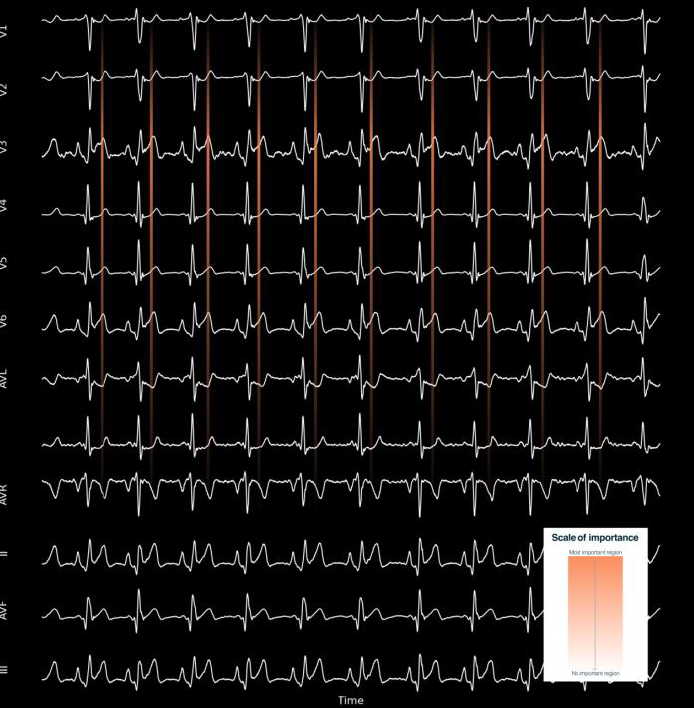
Figure 2. Example of a sensitivity map for understanding the region where the AI algorithm is focusing to predict an output. The most important region is in orange, and the least important regions are in black.